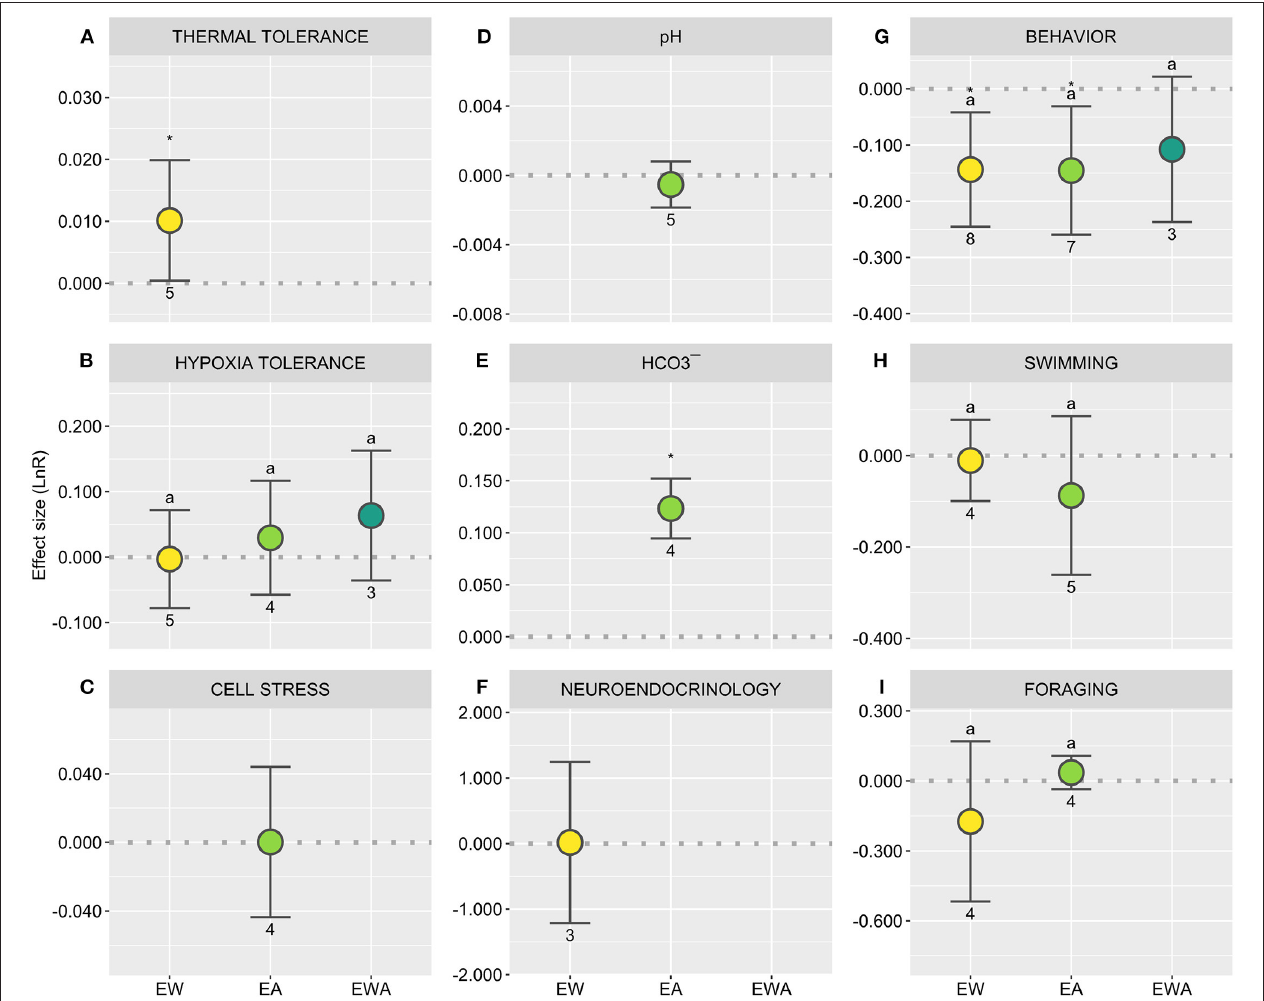
FIGURE 6 | Directional effect sizes (LnR) of experimental warming (EW), acidification (EA), and their combination (EWA) over elasmobranchs, considering specific biological responses [ (A) Thermal tolerance; (B) Hypoxia tolerance; (C) Cell stress; (D,E) Acid-base status; (F) Neuroendocrinology; (G–I) Behavior]. The dashed line ( R = 0) represents the threshold used to test the null hypothesis, with overlapping confidence intervals (CI) indicating the lack of significant treatment effect. R values above 0 indicate a stimulation and below indicates an inhibition of the response; asterisks indicate a significant effect; close trends are also noted. Different letters showcase differences between treatments; numbers indicate sample sizes (number of control-treatment contrasts). Statistical results are detailed in Supplementary Table 3